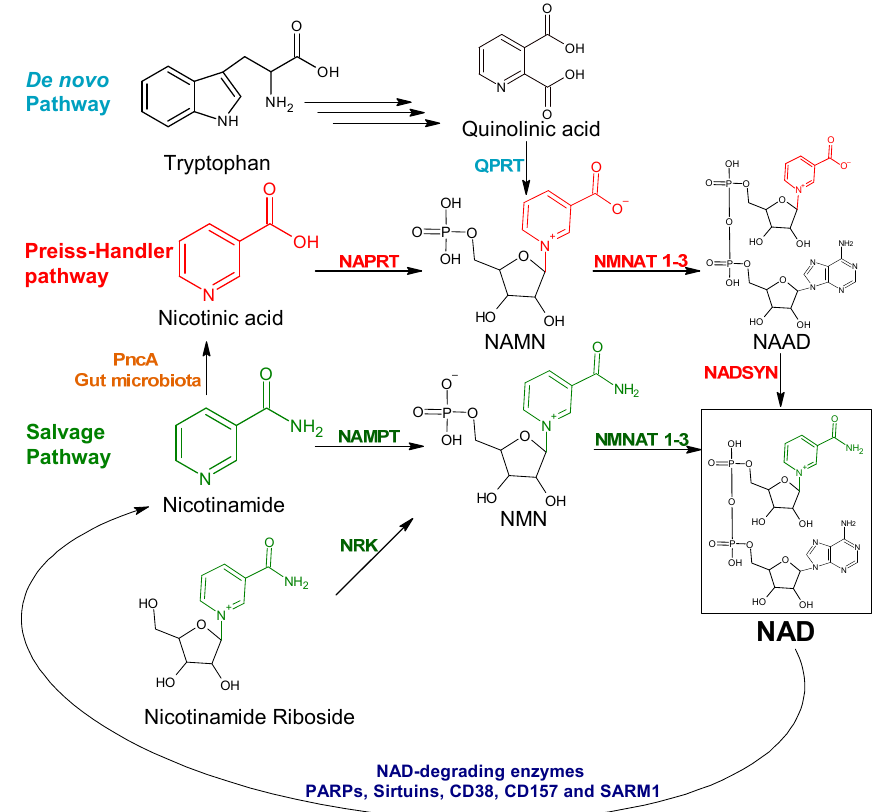
Figure 1. Schematic representation of the NAD–generating pathways in mammalian cells. NAMN, nicotinic acid mononucleotide; NMN, nicotinamide mononucleotide; NAAD, nicotinic acid ade- nine dinucleotide; NAD, nicotinamide adenine dinucleotide; QPRT, quinolinate phosphoribosyl- transferase; NAPRT, nicotinic acid phosphoribosyltransferase; NAMPT, nicotinamide phospho- ribosyltransferase; NRK, nicotinamide riboside kinase; NMNAT, nicotinamide mononucleotide adenylyltransferase; NADSYN, nicotinamide adenine dinucleotide synthetase; PncA, nicotinami- dase; SARM1, sterile alpha and toll/interleukin receptor [TIR] motif-containing protein 1; PARPs, poly(ADP-ribose)